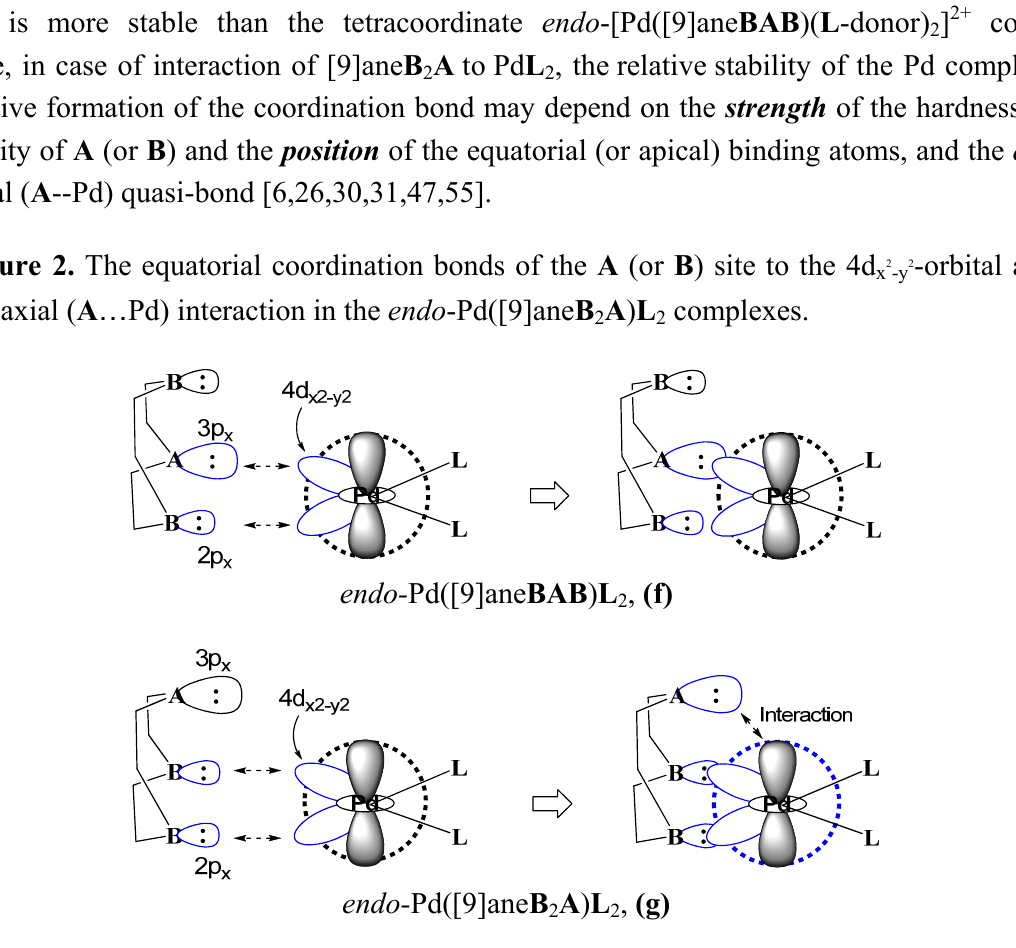
Figure 2. The equatorial coordination bonds of the A (or B ) site to the 4d the axial ( A … Pd) interaction in the endo -Pd([9]ane B